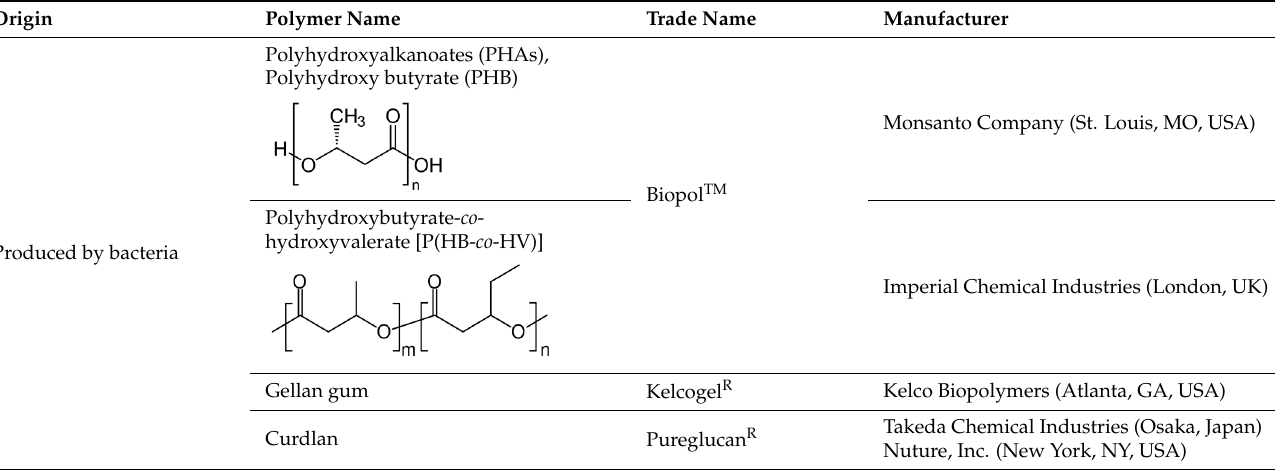
Table 1. Classification of typical commercially available biodegradable polymers based on their origins, together with the trade names and manufacturers [9,10].